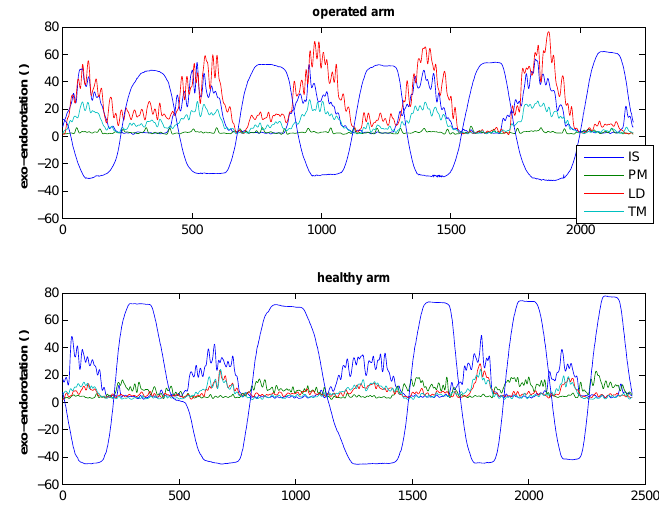
Figure 3. EMG and rotation angle over time for the patient showing more LD activity (red line) in the operated arm.